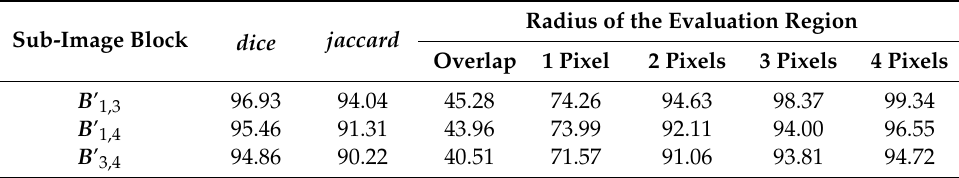
Table 1. Boundary-based riverway extraction accuracy (%).